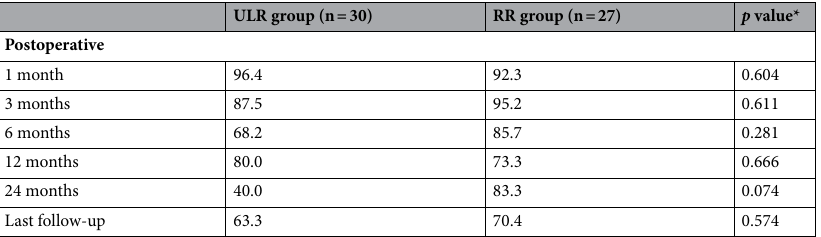
Table 4. Surgical success rates (%) in ULR and RR group. Surgical success = an alignment between 10 PD of exodeviation and 5 PD of esodeviation at distance and near. ULR group patients who underwent unilateral lateral rectus recession, RR group patients who underwent unilateral lateral rectus recession-medical rectus resection. *Fisher’s exact